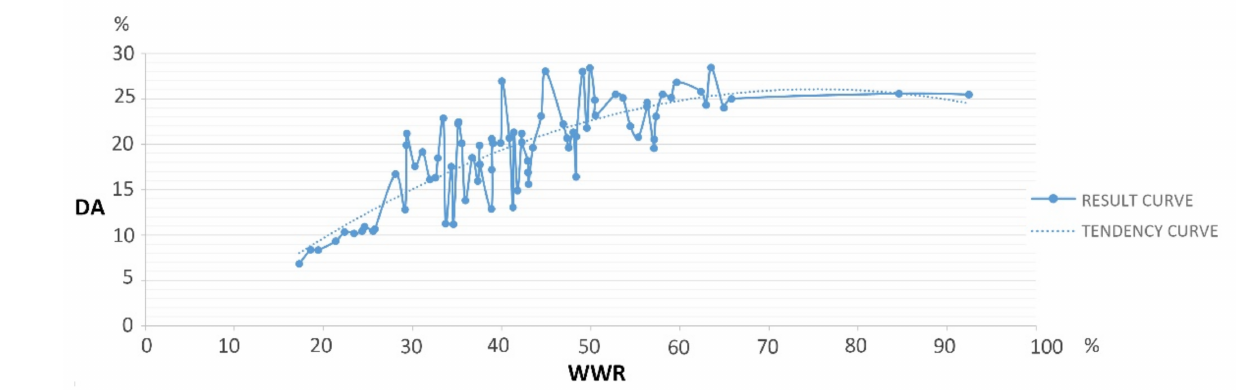
Figure 10. Relationship between DA (y-axis) and WWR (x-axis).